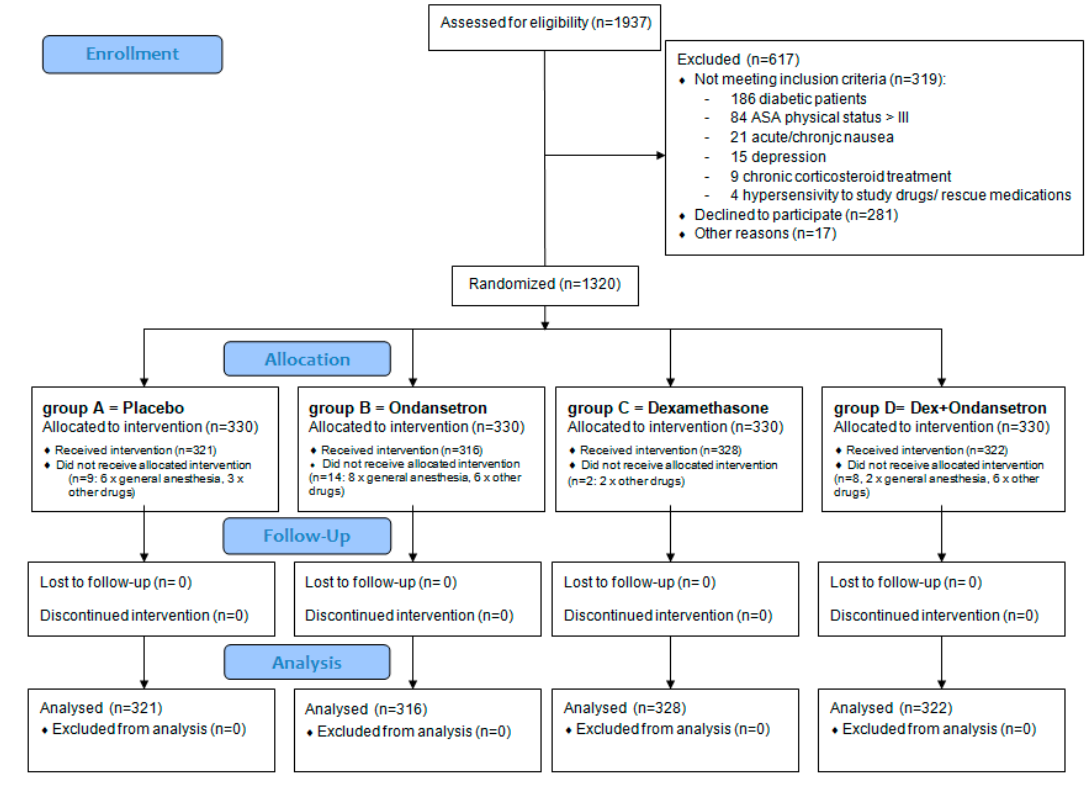
Figure 1. Recruitment flowchart. Table 1. Baseline demographic and systemic characteristics, preoperative and intraoperative data.